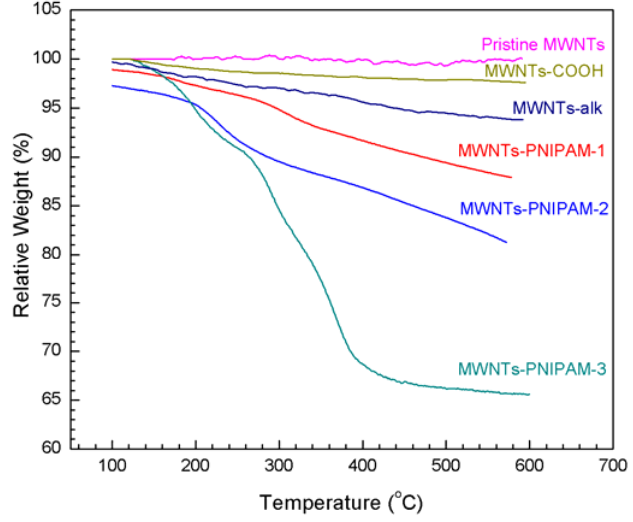
Figure 1. Comparison of the weight losses of pristine MWNTs, MWNTs-COOH, MWNTs-alk, MWNTs-PNIPAM-1, MWNTs-PNIPAM-2 and MWNTs-PNIPAM-3. The data is measured by